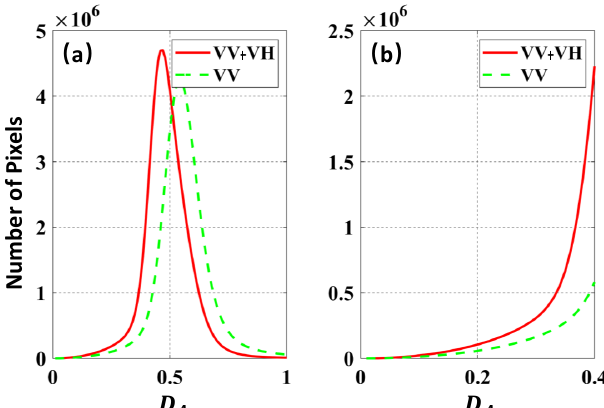
Figure 4. ( a ) Amplitude dispersion index ( D A ) histograms derived by the VV channel and PolPSI- ADI approach (VV+VH) over Beijing test site. ( b ) is the detailed zoom of ( a ) for D A values from 0 to